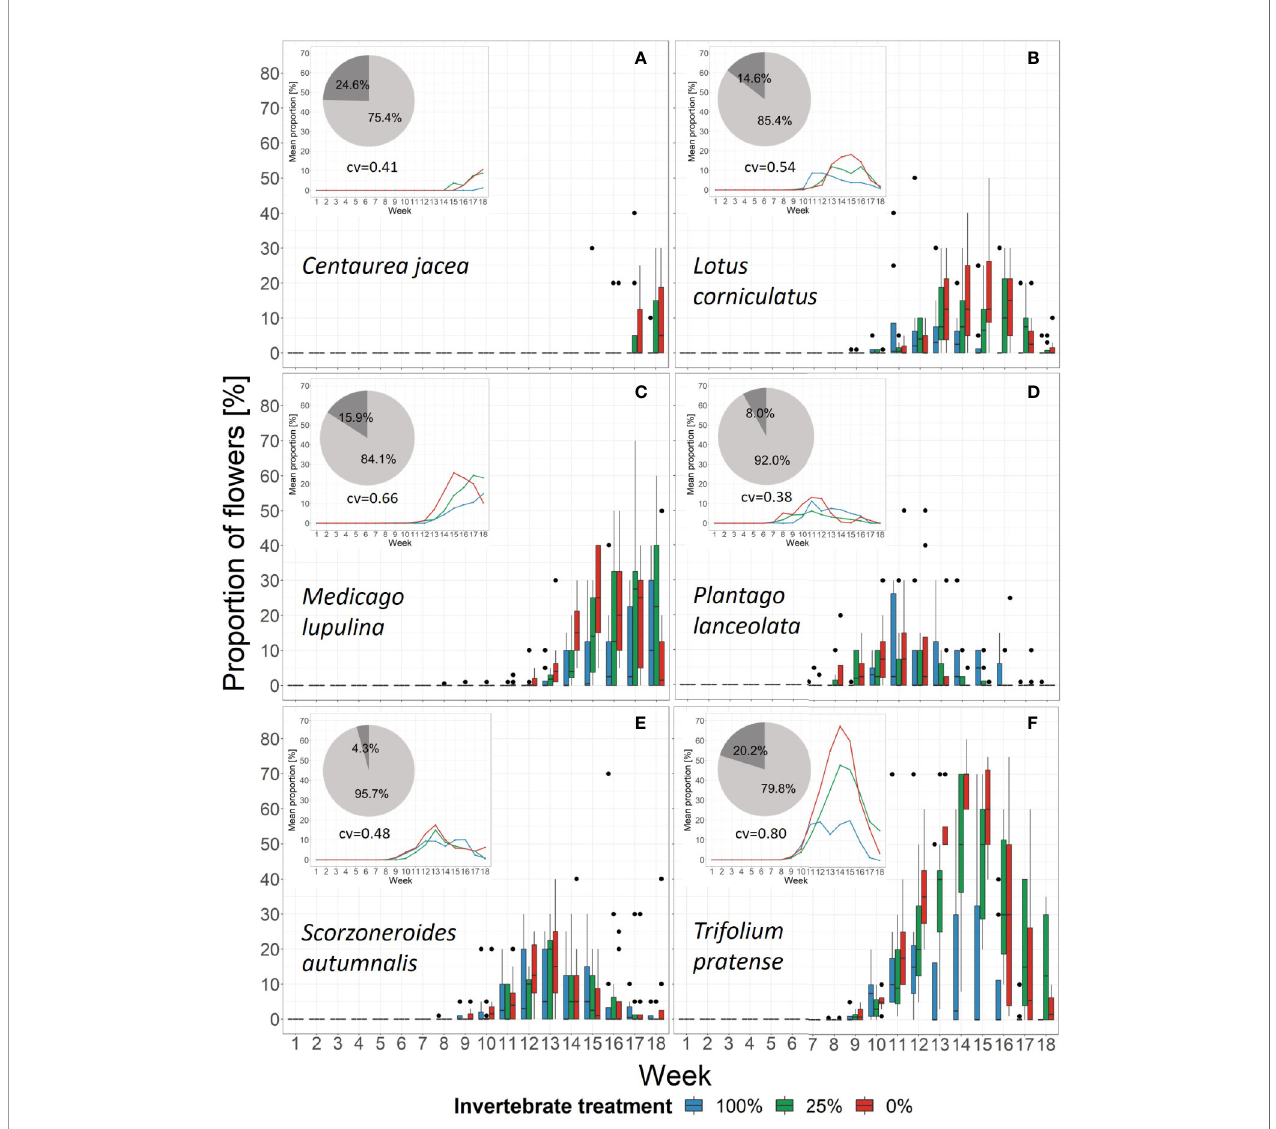
FIGURE 5 | Changes in the proportion of fl owers of the six plant species in each treatment over time. Black dots mark outliers. Small windows give the mean proportion of the same species within the community as lines. Pie charts show the relative importance based on boosted regression trees of the variables week (light grey) and treatment (dark grey). Underneath the pie chart the cross-validation of the models is given (cv). See Supplementary Figure 7 for partial dependence plots. (A) Centaurea jacea , (B) Lotus corniculatus , (C) Medicago lupulina , (D) Plantago lanceolata , (E) Scorzoneroides autumnalis , (F) Trifolium pratense